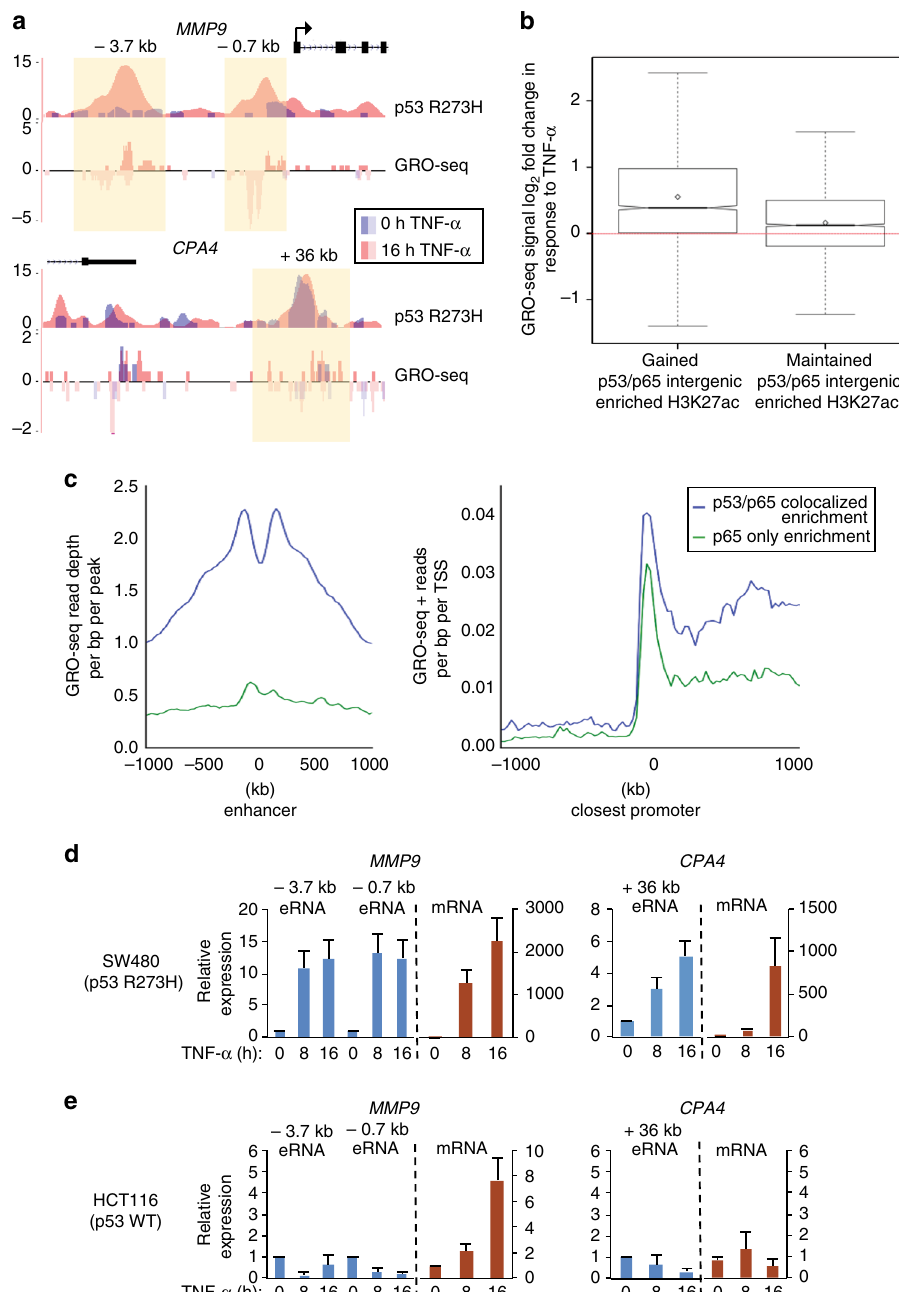
v ee t i l a R e Fig. 4 Mutp53 enhancer binding is positively correlated with enhancer transcription. a UCSC genome browser images for MMP9 and CPA4 gene loci showing the ChIP-seq signal for mutp53 binding and GRO-seq peaks with the enhancer regions highlighted in yellow. b Boxplots showing log 2 fold change in response to TNF- α in GRO-seq signal of nascent transcripts centered upon intergenic gained or maintained mutp53 peaks that overlap with NF κ B and H3K27ac peaks. c Analyses of (left) GRO-seq reads per bp per intergenic ChIP-seq peaks of mutp53 and NF κ B/p65, as indicated, and (right) GRO-seq reads per bp per TSS at promoters closest to intergenic ChIP-seq peaks de fi ned in the left panel. d qRT-PCR analyses of the indicated eRNAs and mRNAs in SW480 cells and e HCT116 cells treated with TNF- α for 0, 8, or 16 h. The expression levels shown after TNF- α treatment are relative to the levels before treatment. The bar graphs represent the average of three independent experiments with the error bars denoting the standard